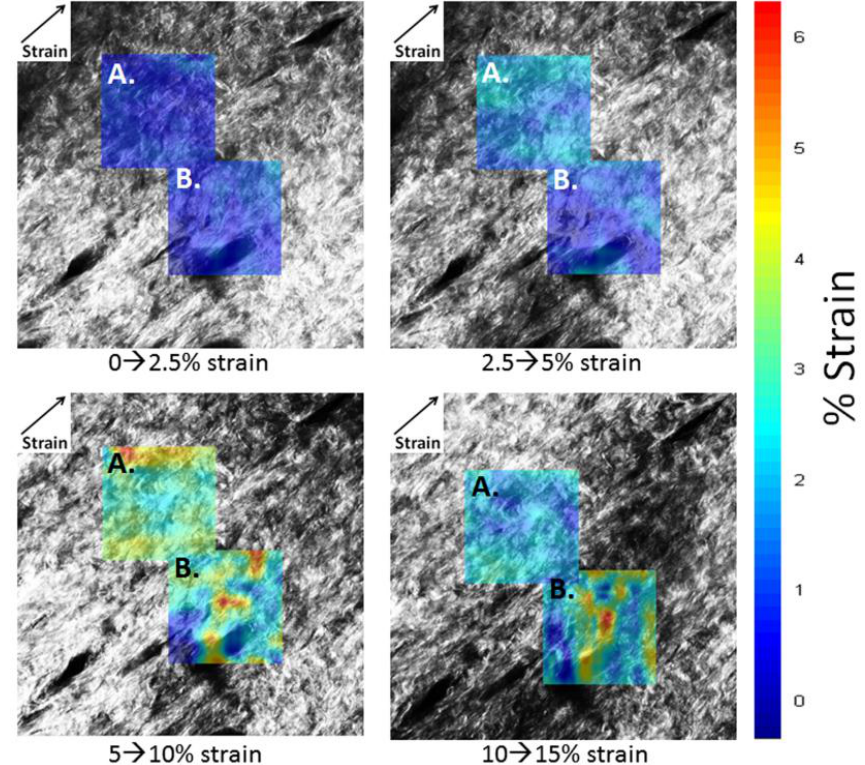
Figure 4. Maximum and minimal principal strains were averaged over three different regions; collagen matrix region (white box denoted by A ), surrounding hair follicle collagen (black box denoted by B ), and hair follicle collagen, (which is the area covered by the white ellipse C ). The direction of applied deformation is indicated in the upper left hand corner.